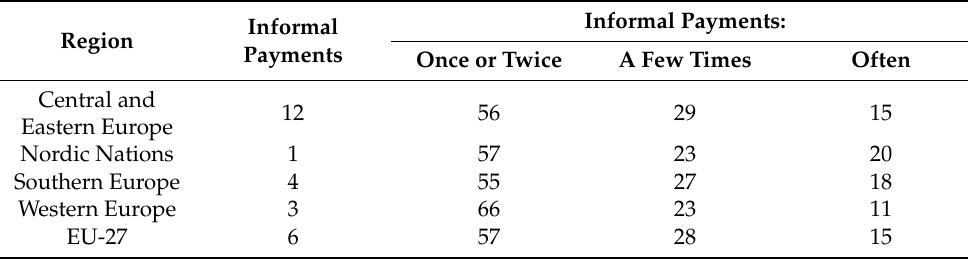
Table 1. Public clinic or hospital users making informal payments, by EU region ( n = 25,744; %).